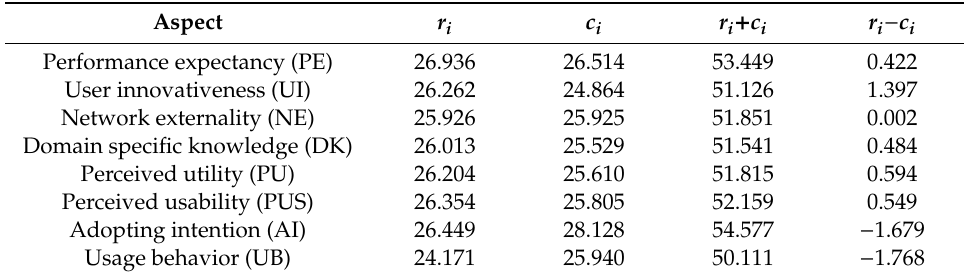
Table A6. r i + c i and r i − c i values obtained from the total influence matrix T